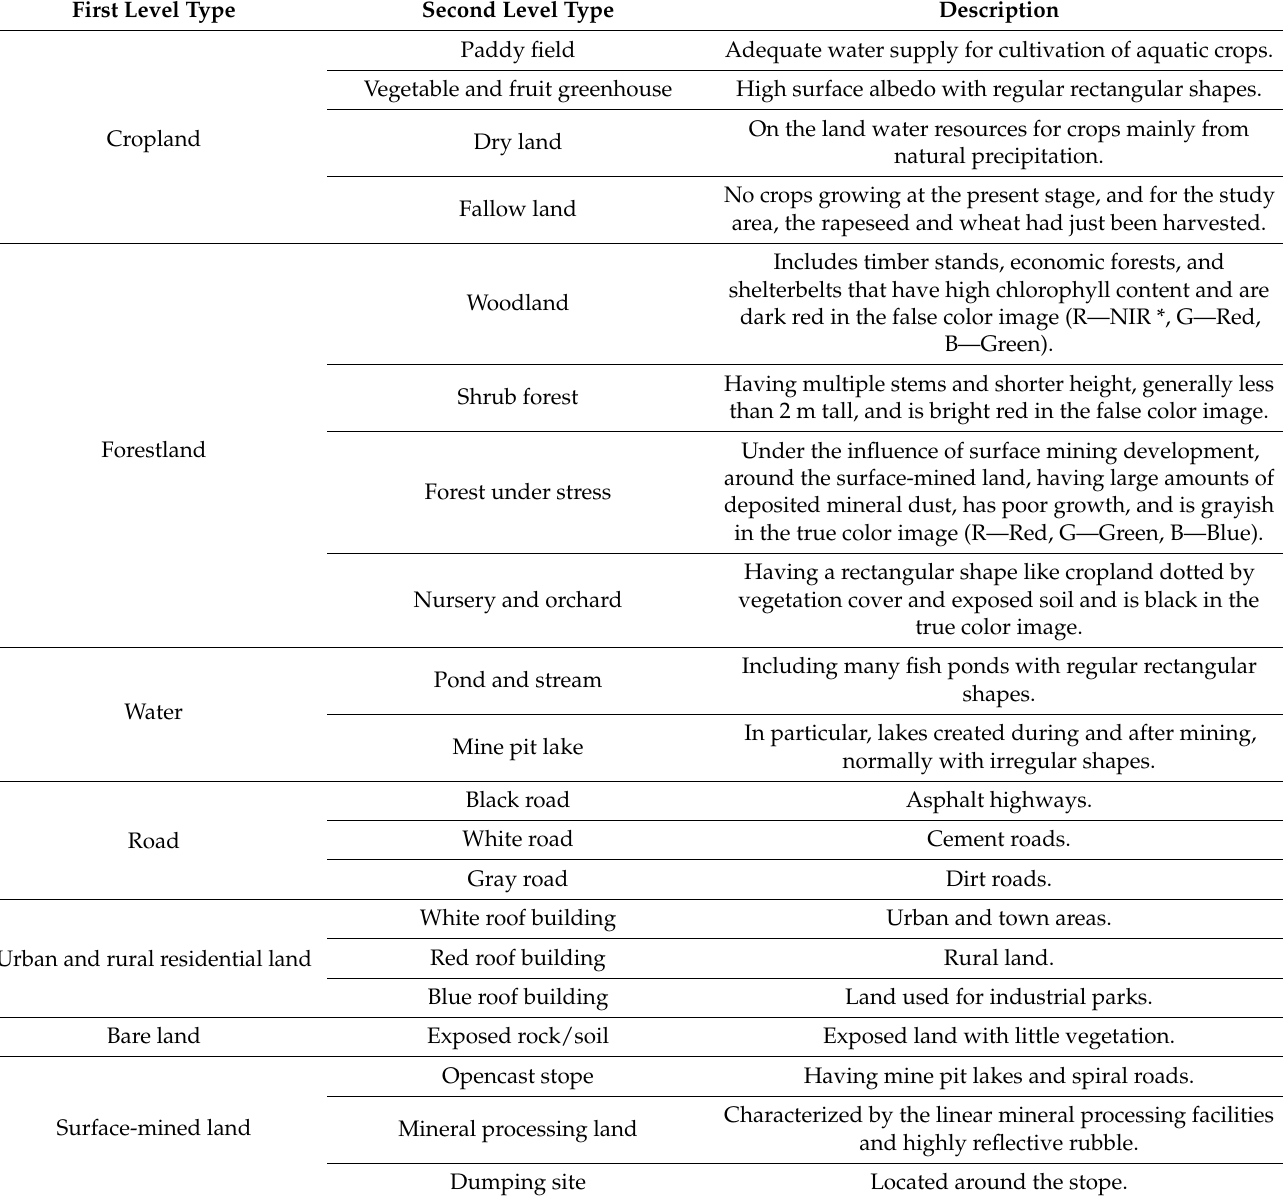
Table 1. Summary of the land cover types involved in this study and their description from